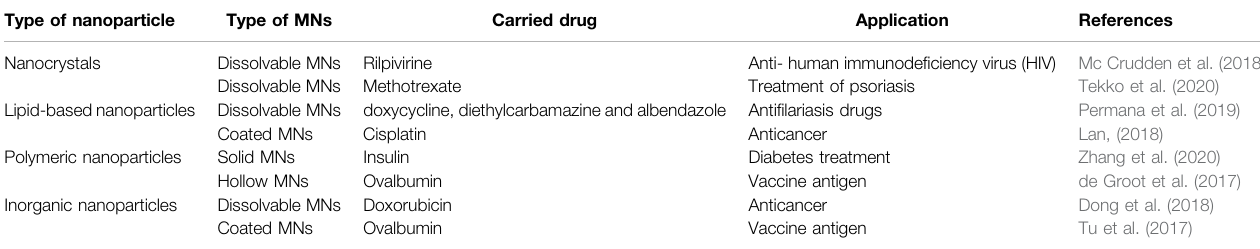
TABLE 2 | The representative applications of transdermal delivery of drug-loaded nanoparticles via MNs. Type of